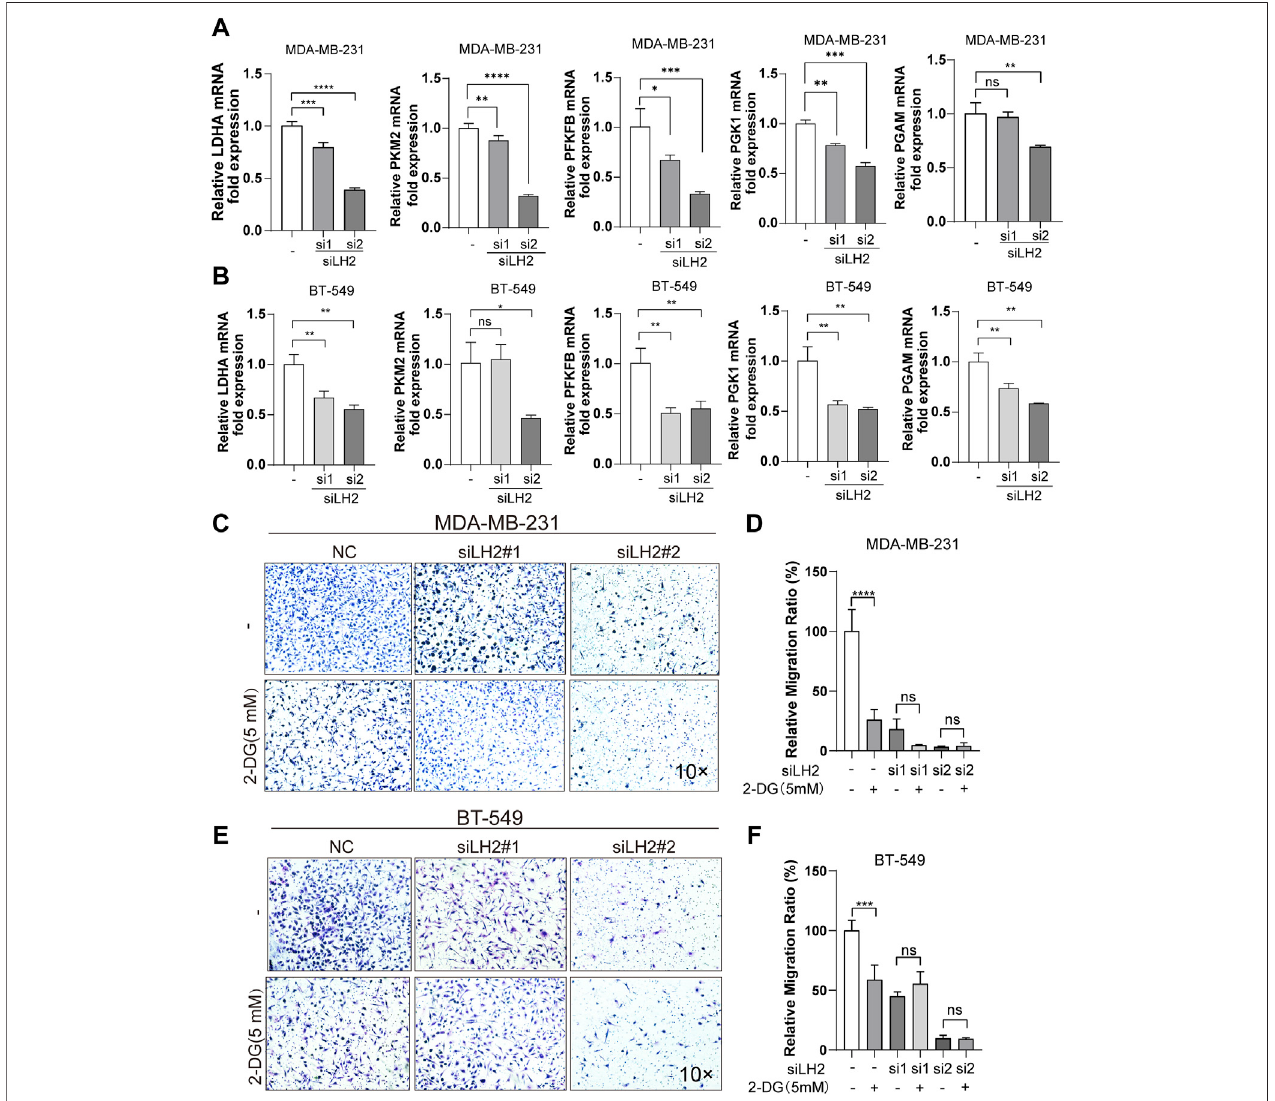
FIGURE 5 | Inhibition of the LH2 constrains TNBC cell migration primarily through glycolysis modulation. (A – B) mRNA expression of glycolytic enzymes including PGK1, LDHA, PFKFB, PKM2, and PGAM in the MDA-MB-231 or BT-549 cells after LH2 silencing. (C – F) Representative images of the MDA-MB-231 or BT-549 cells treated with 2-DG (5 mM) or not after LH2 silencing. All the results were representative of three independent experiments. 10 × scale bars, 200 μ m ** p < 0.01, *** p < 0.001, **** p < 0.0001 vs. the control or nc cells.